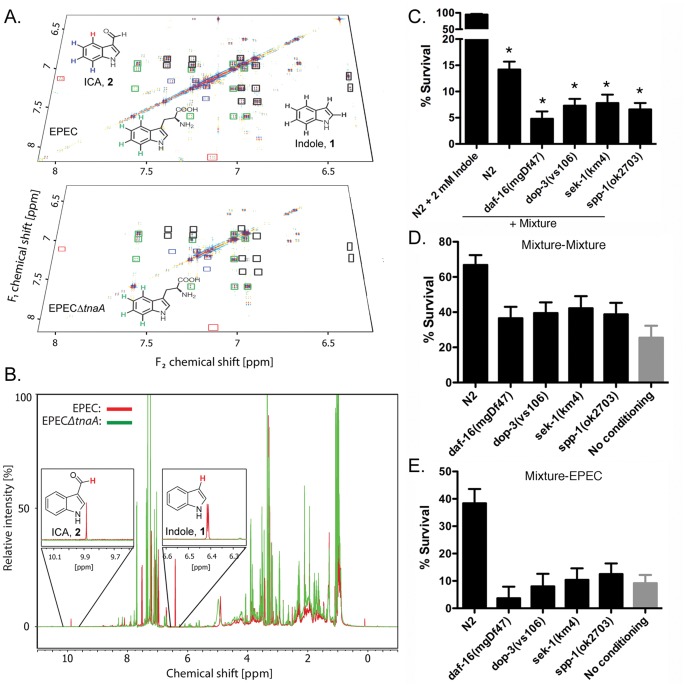
Identification of indole derivatives by two-dimensional NMR-based comparative metabolomics.(a) DANS overlay of the aromatic region of a dqfCOSY spectra obtained for the EPEC and EPECΔtnaA extracts highlights differentially present compounds in the EPEC extract. Crosspeaks representing colored protons in the shown indole structures are highlighted by correspondingly colored boxes. For example, the crosspeaks marked with a red box corresponds to a de-shielded protons of ICA, which is present in the EPEC spectrum but absent in the EPECΔtnaA spectrum. (b) Overlay of 1H-NMR spectra from the EPEC extract (red) and the EPECΔtnaA (green). Signals representing indole (zoom of 6.4 ppm) and the aldehyde proton in ICA (at 9.9 ppm) are present in the EPEC spectrum but absent in the EPECΔtnaA spectrum. (c) Reconstitution of killing with 2 mM indole in combination with 0.6 mM ICA and 0.2 mM IAA. Mean +/− SEM are shown; * corresponds to p<0.01 with respect to N2. (d,e) Pre-exposure of N2 or various mutants to the indole/ICA/IAA mixture for 30 minutes followed by a 3 hour waiting period on OP50, and then a 3 hour challenge with either the mixture (d) or EPEC (e). Note that killing and conditioning with the mixture closely resembles that seen with EPEC, and utilizes the same gene products in C. elegans. In d-e, mean +/−95% confidence intervals are shown. Lack of overlapping error bars indicates significance at the 5% level.